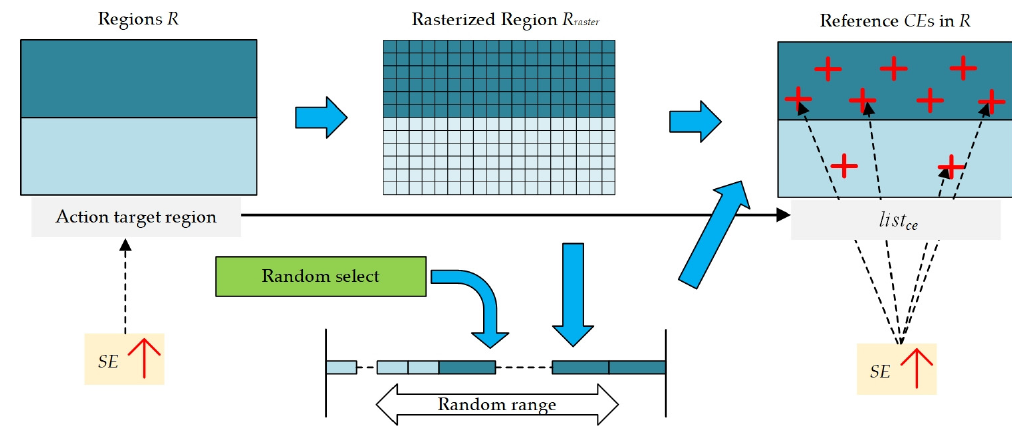
Figure 3. Express the fuzziness of different regions by list ce .